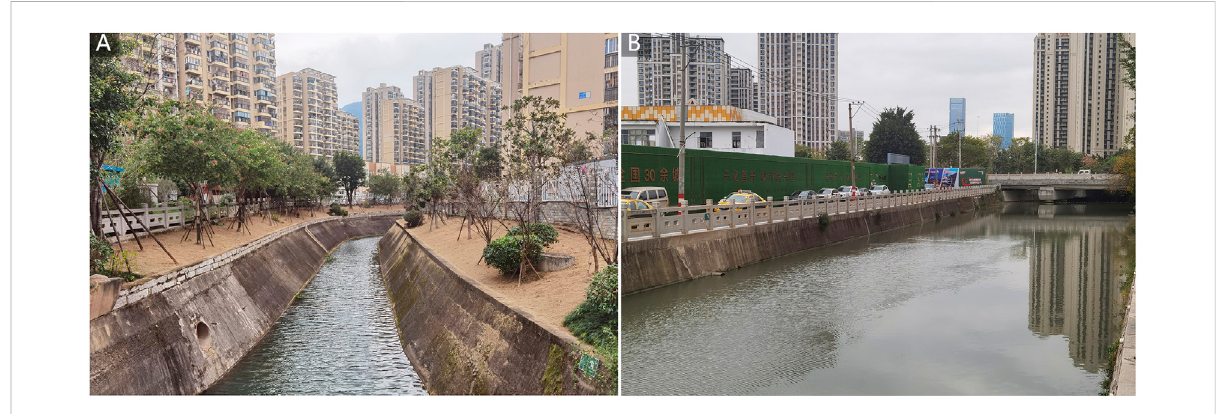
FIGURE 6 Existing wetland matrix. (A) Moyang River and (B) Huagong